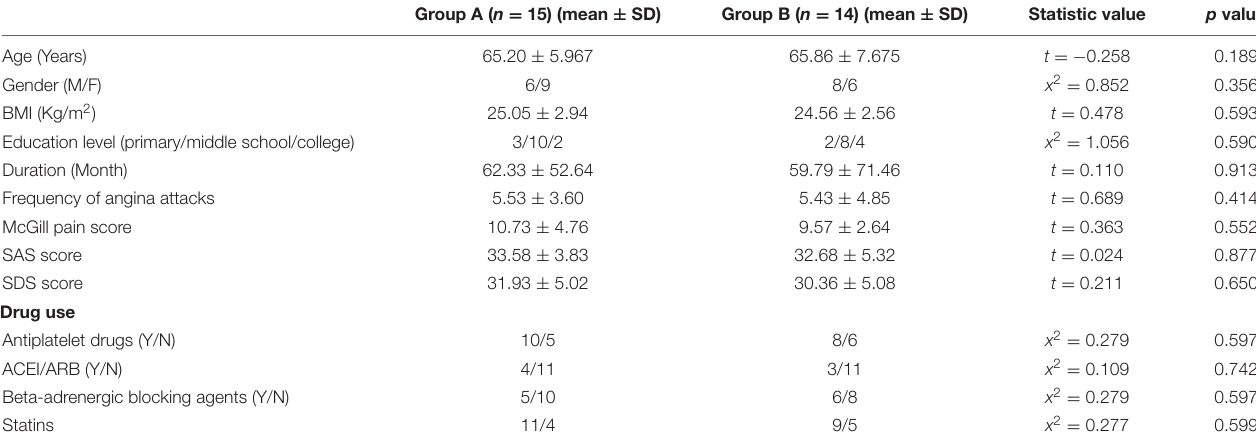
TABLE 2 | The between-group comparison of demographic characteristics and baseline conditions of CSAP patients in these two acupuncture groups.